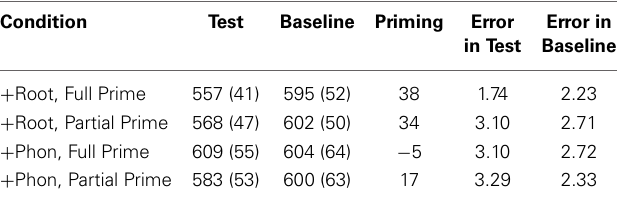
Table 2 | Reaction times, (standard deviations), amount of priming, and %error rates for the target preceded by test and baseline primes in the different conditions of experiment